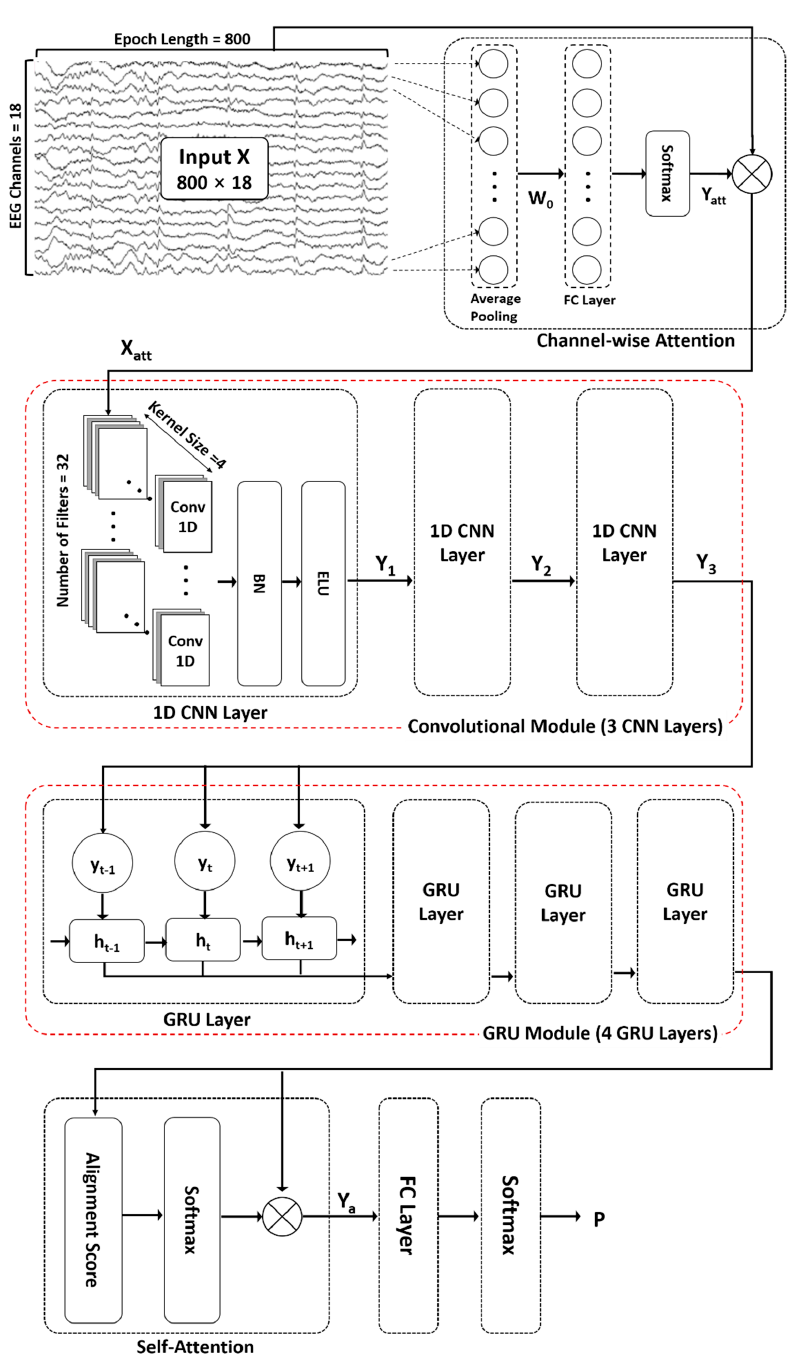
Figure 1. The proposed attention-based convolutional gated recurrent unit model (ACGRU). The model includes three one-dimensional convolutional layers (Conv1D) and four gated recurrent units (GRUs) combined with channel-wise attention mechanisms to capture temporal and spatial information of a four-second input epoch (800 data points × 18 channels). Captured patterns were